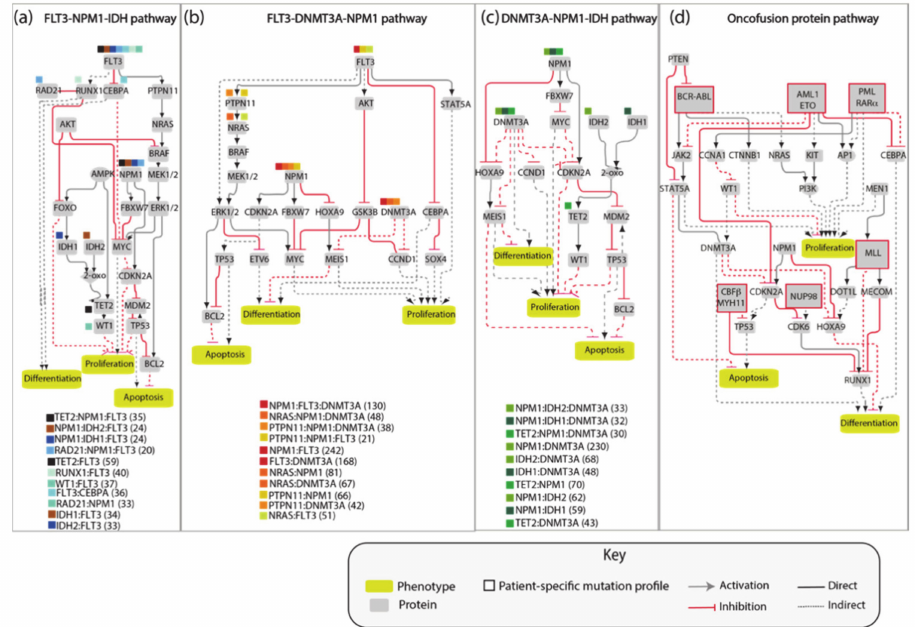
Figure 4. AML modules. Schematic of four AML-specific pathways recapitulating the mechanisms modulated by the most frequently identified co-occurring mutations ( a – c ) and onco-fusion proteins ( d ). For each of the three graphs in ( a – c ), the gene combinations that are frequently found mutated in patients are listed below the graph and assigned a colored square. In parenthesis are the number of occurrences in the cohort of 1540 AML patients [8]. The colored squares, assigned to the gene combinations, are used in the graphs to label the co-occurring